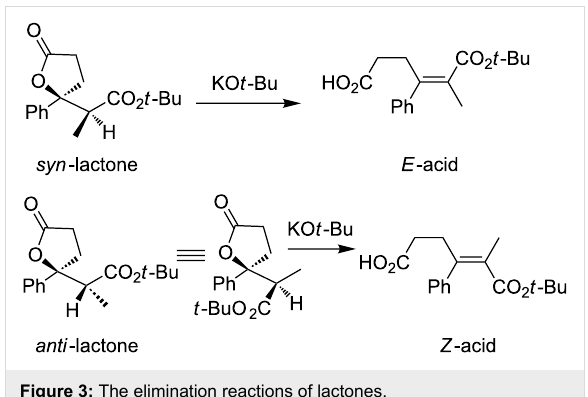
Figure 3: The elimination reactions of